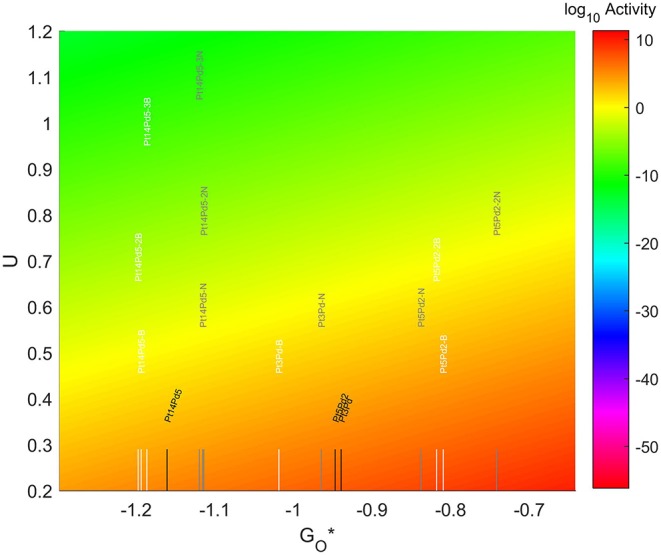
Volcano plot for ORR activity of Pt-Pd 4-atom, 7-atom, and 19-atom TMNP-doped-MDG. 4/7/19 atom systems are Pt3Pd1, Pt5Pd2, and Pt14Pd5, respectively.